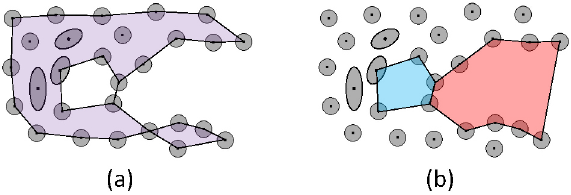
Fig. 22 A fiber-deficient area divided by a dangling edge: (a) α -shape, (b) two fiber-deficient areas.